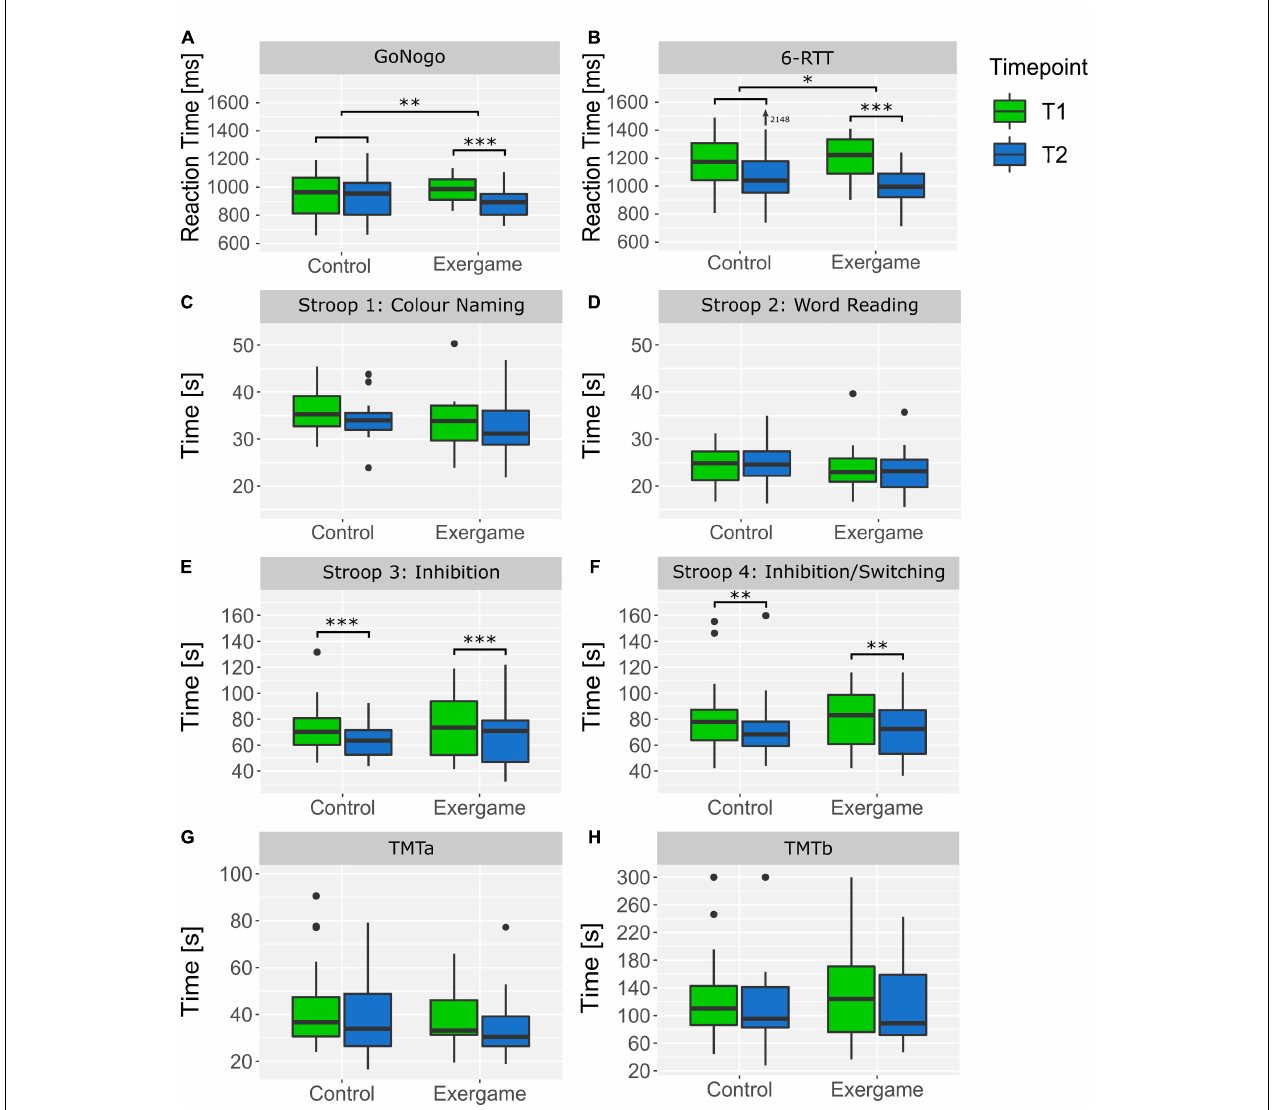
FIGURE 4 | Boxplots of cognitive outcomes of each group at pre- and post-measurements. (A) Reaction Time in the Go/No-Go Test on the Dividat Senso, (B) Reaction Time in the 6-Step Reaction Time test (SRTT) on the Dividat Senso, (C) Time required for the first Stroop task (Color Naming), (D) time required for the second Stroop task (Word Reading), (E) time required for the third Stroop task (Inhibition), (F) time required for the fourth Stroop task (Inhibition/Switching), (G) time required for the Trail Making Test (TMT) part A, (H) time required for the Trail Making Test (TMT) part B. ∗ P < 0.05, ∗∗ P < 0.01, ∗∗∗ P <